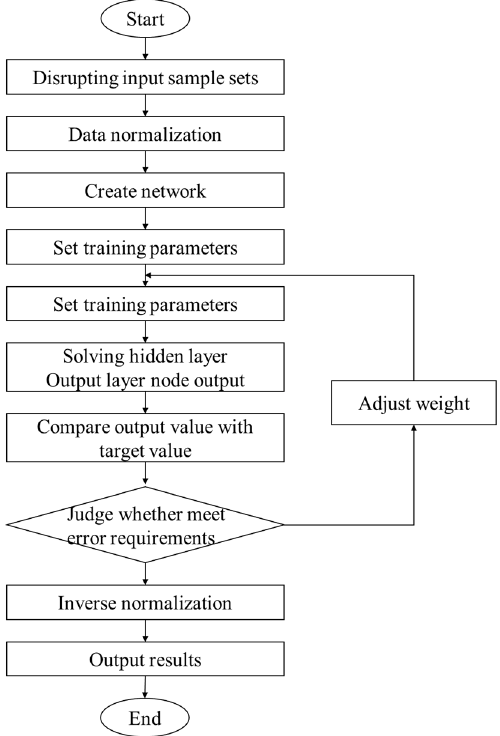
Figure 3. Programming flowchart of BP neural network algorithm.